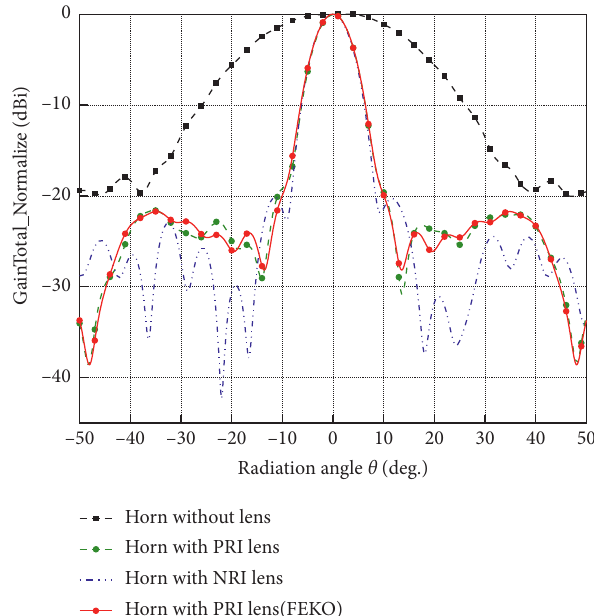
Figure 6: Radiation patterns of the horn antenna and the horn with PRI lens and NRI